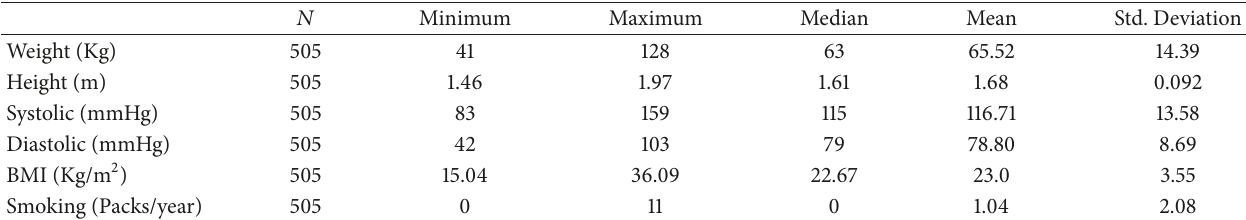
Table 1: Mean, standard deviation, minimum, and maximum for the included sample’s measurements.